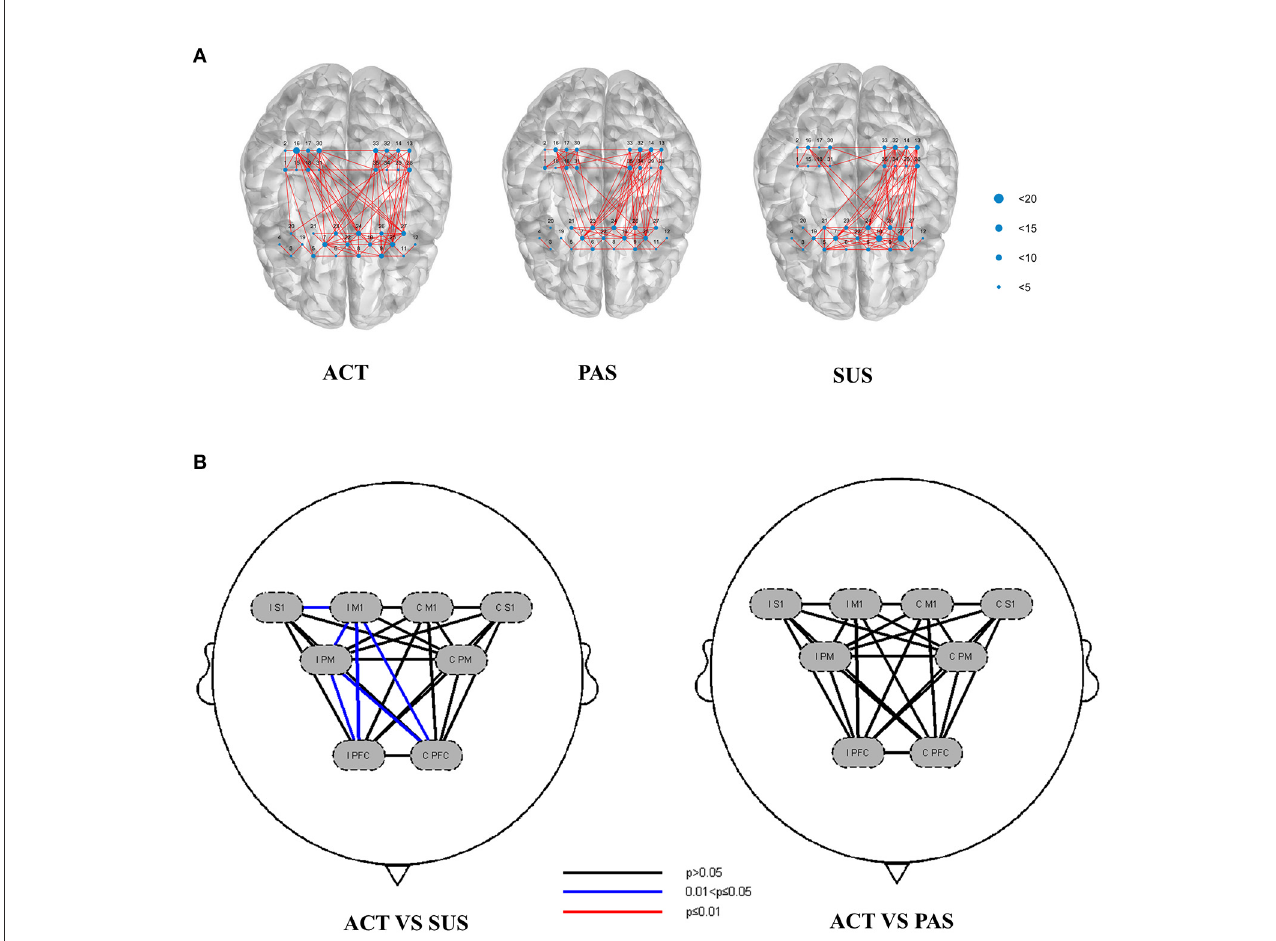
FIGURE5 (A) Functional connectivity (FC) of ROIs during ACT, PAS, and SUS. (B) Channels with differences in FC between ACT and SUS (Pearson correlation), and there was no significant difference in FC between ACT and PAS. ROIs, regions of